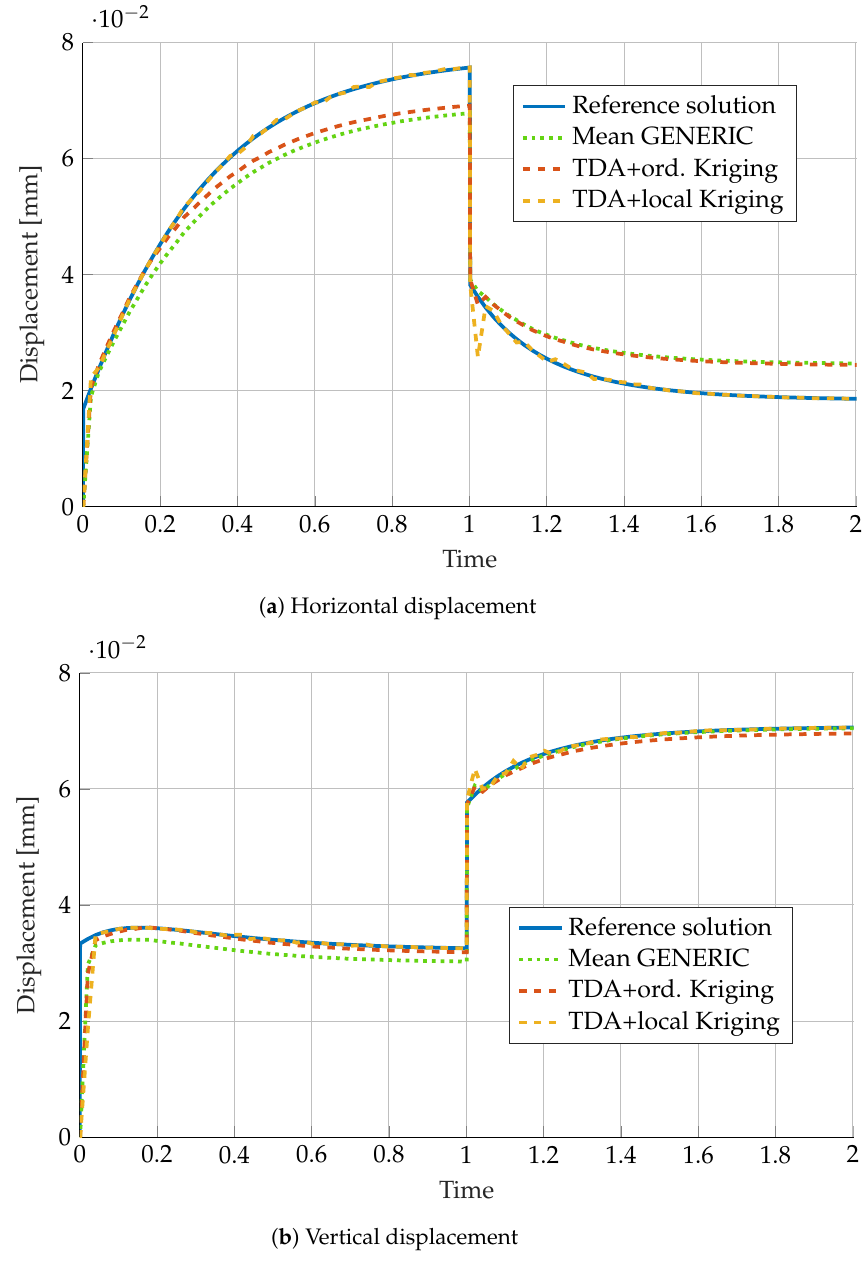
Figure 6. Comparison of ( a ) horizontal and ( b ) vertical displacement predicted by a GENERIC model obtained as the mean of 50 different noisy GENERIC models. Comparison with the noise-free reference solution in continuous blue line and the solutions obtained by Kriging interpolation between neighbors predicted by Topological Data